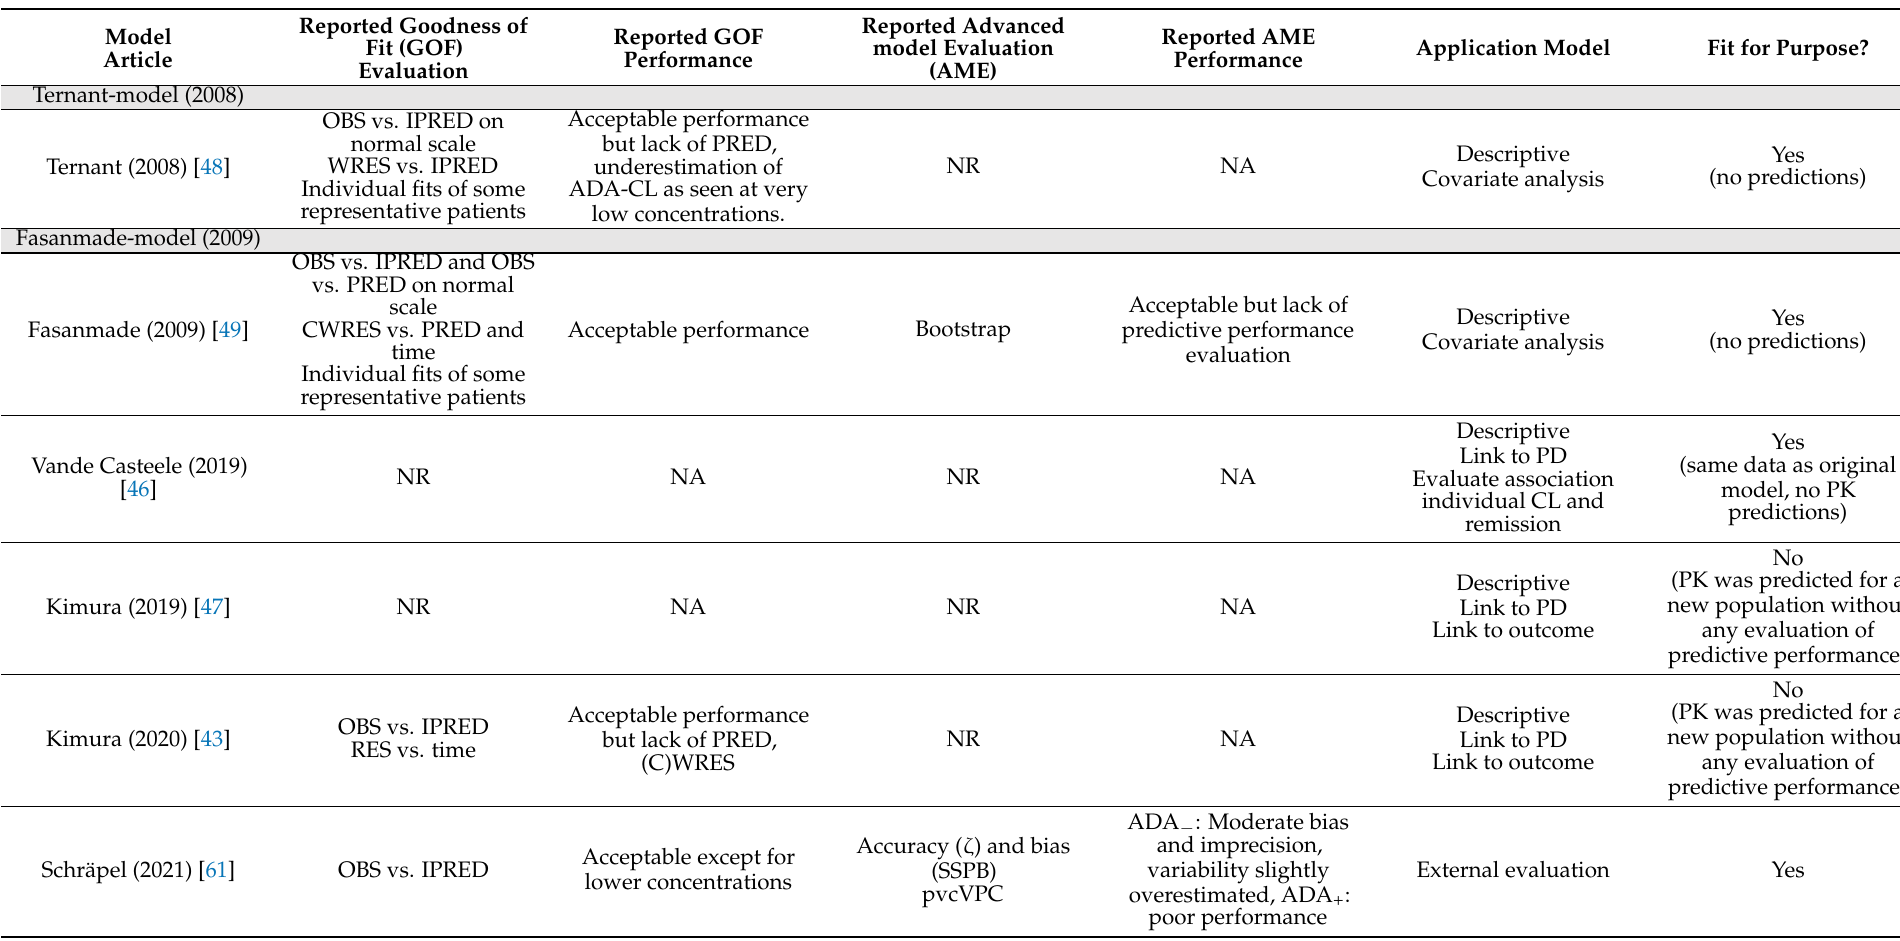
Table 3. Reported model performance and evaluation of the published models and their